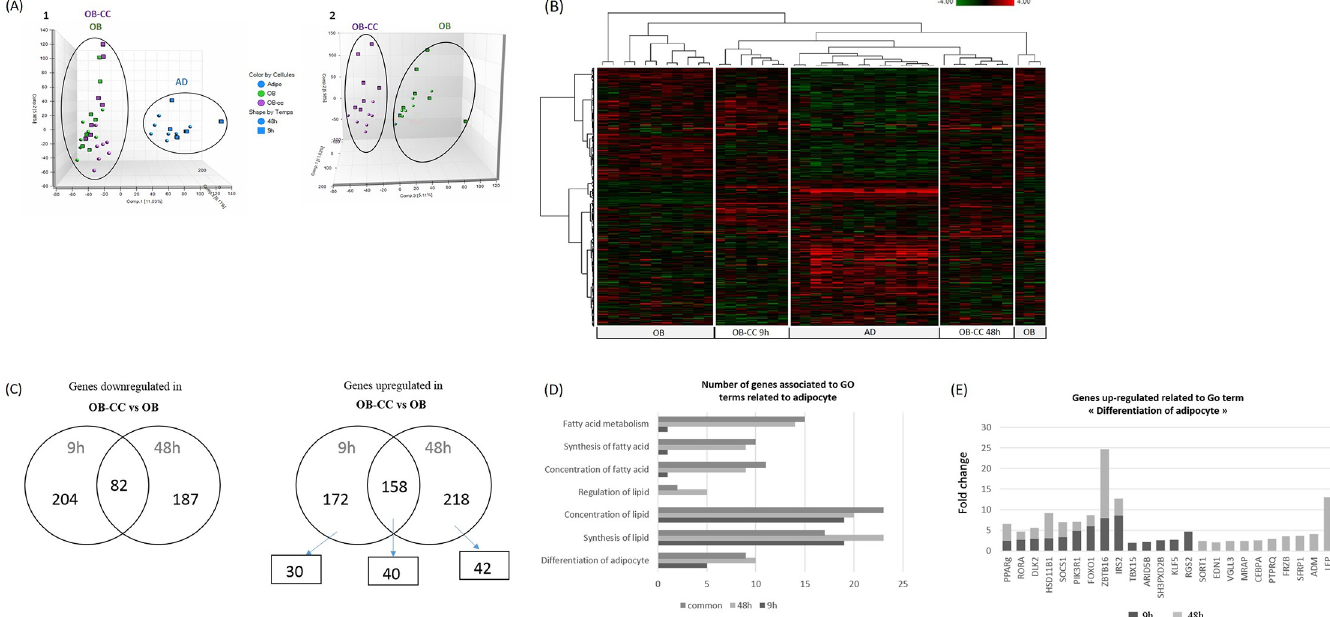
Fig 2. Dynamic transcriptional changes upon coculture. (A) Principle component analyses of AD (blue) and OB cells (OB-CC and OB) (1) and OB-CC (pink) and OB (green) (2) using the 30,413 probes that were detected as expressed upon 9 h of coculture (squares) or 48 h (circles). (B) Hierarchical clustering of genes that were differentially expressed in AD and OB cells and OB-CC after 9 h and 48 h of coculture. Each row represents an individual gene, and each column represents an individual sample. Relative expression levels are represented as a colour scale from red for lower expressions to green for higher expressions. (C) Venn diagram showing the number of genes downregulated and upregulated according to the microarray analyses in OB and OB-CC after 9 and 48 h of culture. Boxes indicate the number of upregulated genes related to adipogenesis. (D) Gene ontology (GO) analysis of upregulated genes showed an enrichment of GO terms for biological processes in adipogenesis. The y-axis shows significantly enriched upregulated GO terms in OB-CC versus OB after 9 h and/or 48 h of coculture. The number of upregulated genes for each category is indicated by the ordinate axis. (E) Upregulated expression of genes associated with adipocyte differentiation. The y-axis shows the fold change values for differential expression in OB-CC versus OB after 9 and 48 h of